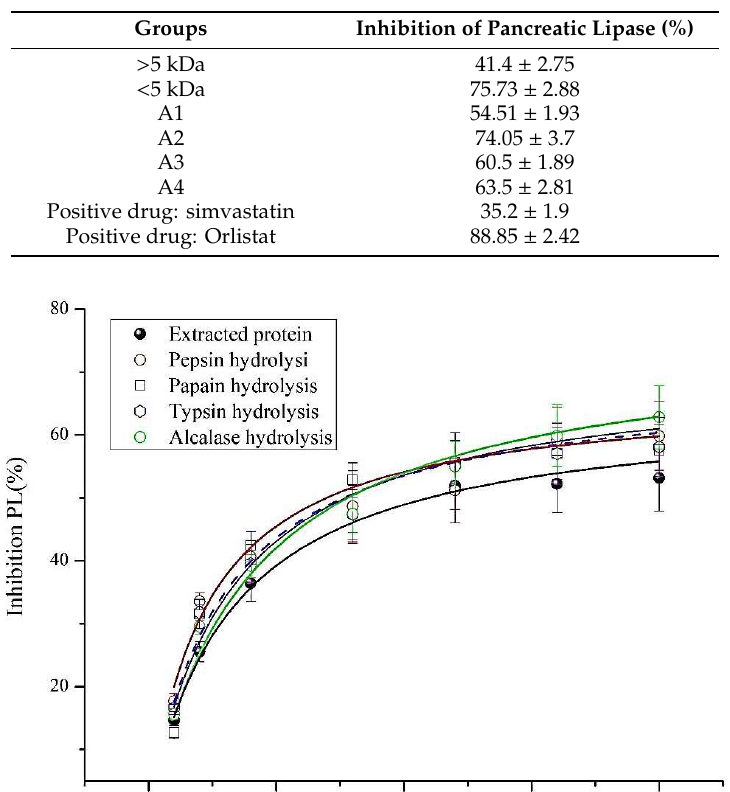
Table 2. Inhibition of pancreatic lipase activity of Alcalase hydrolysate fractions.